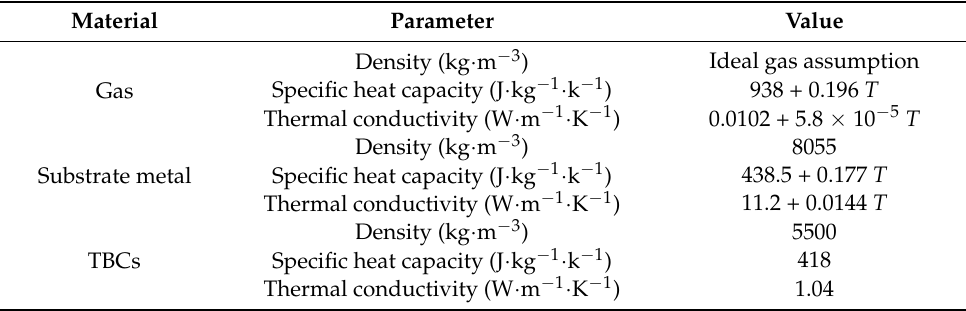
Table 2. Material